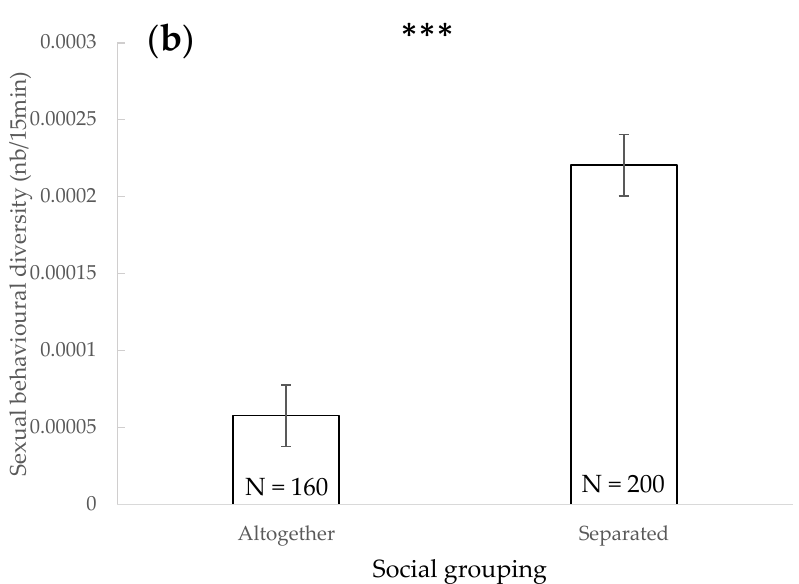
Figure 6. Mean of the sexual behavioural diversity and 95% confidence intervals according to the sex composition ( a ) and social grouping ( b ). ***: p < 0.001; within each factor, categories that share the same letter do not differ significantly and categories that have no letter in common differ significantly (Wald chi-squared test with a sequential Bonferroni correction). N: number of observations.